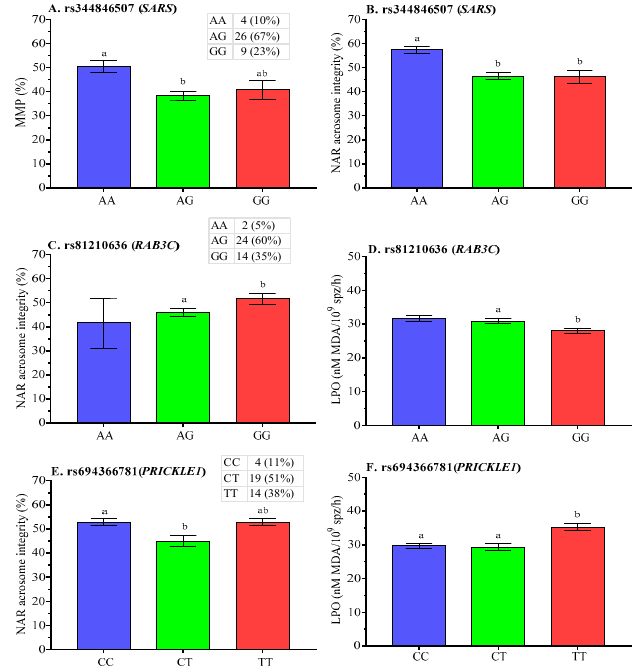
Figure 6. E ff ect of polymorphisms in A–B . SARS, C–D . RAB3C, and E–F . PRICKLE1 genes on post-thaw membrane integrity of boar spermatozoa. Data are presented as the mean ± SEM. a,b Di ff erences between genotypes were significantly di ff erent at p < 0.05.